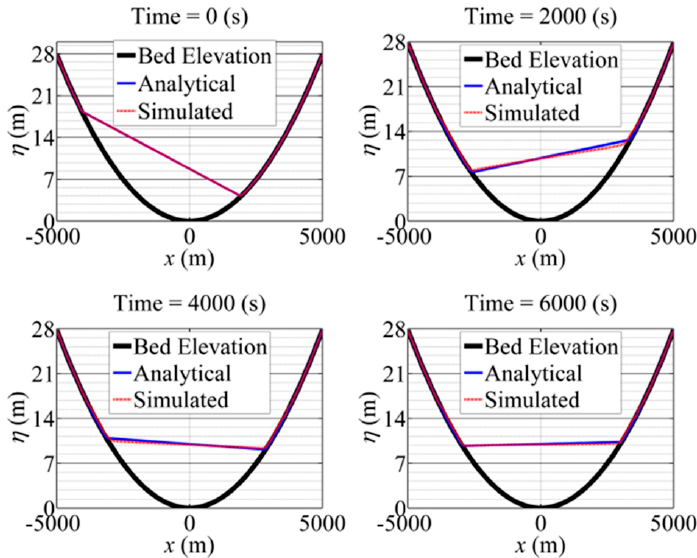
Figure 2. Simulated water surface elevations over a parabolic topography at time = 0 s, 2000 s, 4000 s, and 6000